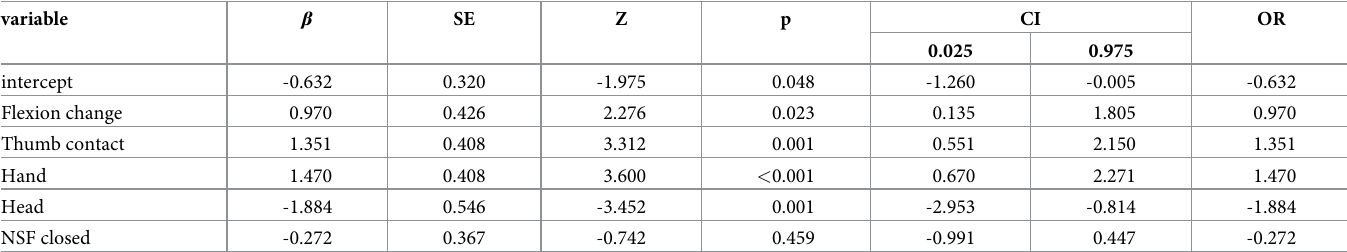
Table 3. Table of model predictors.